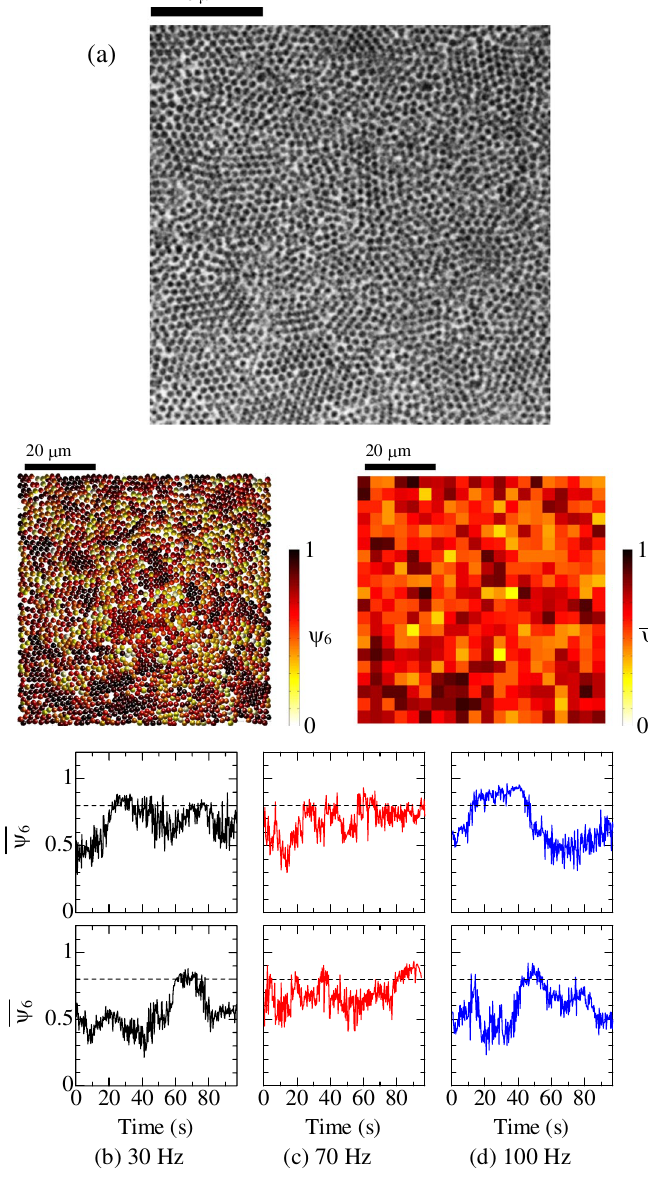
Figure 3. Evolution of ψ during the applications of mechanical oscillation to colloidal glasses. ( a ) A 6 microscope image (top), a reconstructed image showing the distribution of ψ 6 i (bottom left), and a reconstructed image showing ψ per square (bottom right). The evolutions of ψ 6 squares at ( b ) 30 Hz, ( c ) 70 Hz, and ( d ) 100 Hz are plotted. Dashed lines denote the threshold above which crystallization